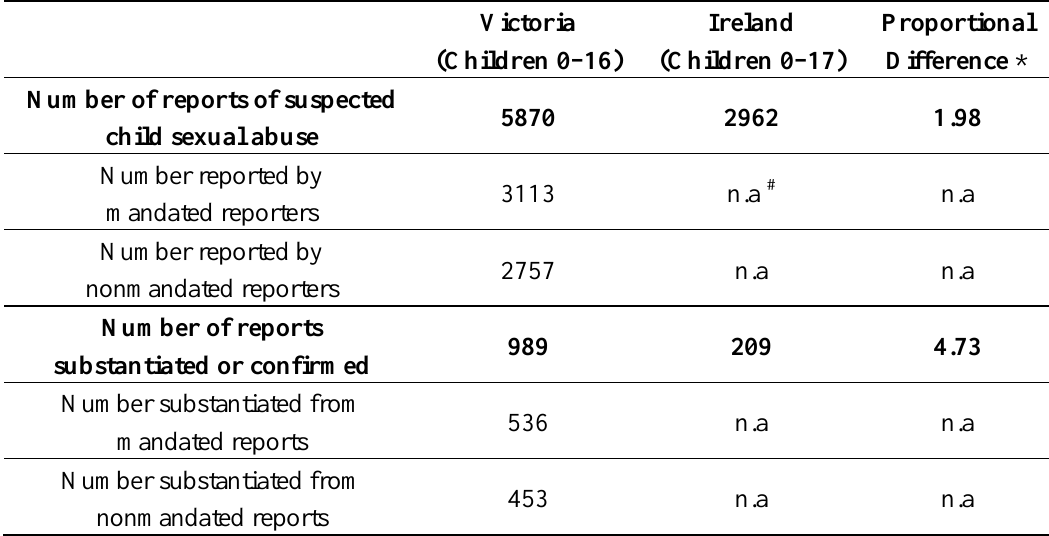
Table 1. Number of reports of suspected child sexual abuse, and number of substantiated reports, in Victoria and Ireland